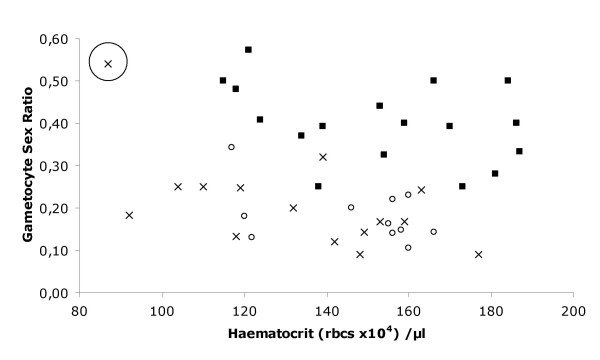
Gametocyte sex ratios (proportion male) of mixed vs. single clone infections compared with the corresponding haematocrit (red blood cell density) measured on the same day of infection. Each individual infection was measured daily for both these parameters until either the host died or the infection was cleared by the host (thus until the peak of infection). Infections were initiated by injection of 106 parasites for single clone treatments and 5 × 105 of each clone in mixed infections. Thai clone (squares); SL clone (open circles); mixed clones (crosses). Circled cross represents one individual that had a high sex ratio associated with a high density of reticulocytes on one particular day (see text).